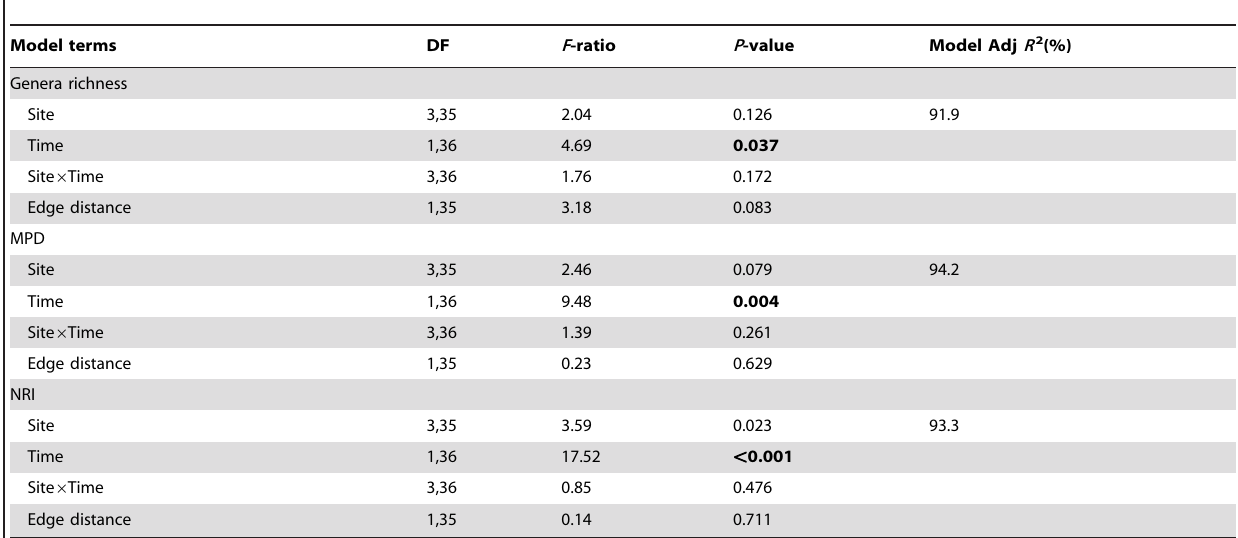
Table 1. Fixed effects of linear mixed models fitted for repeated measures of tree community attributes in a 1000-km 2 forest landscape of Central Amazonia,